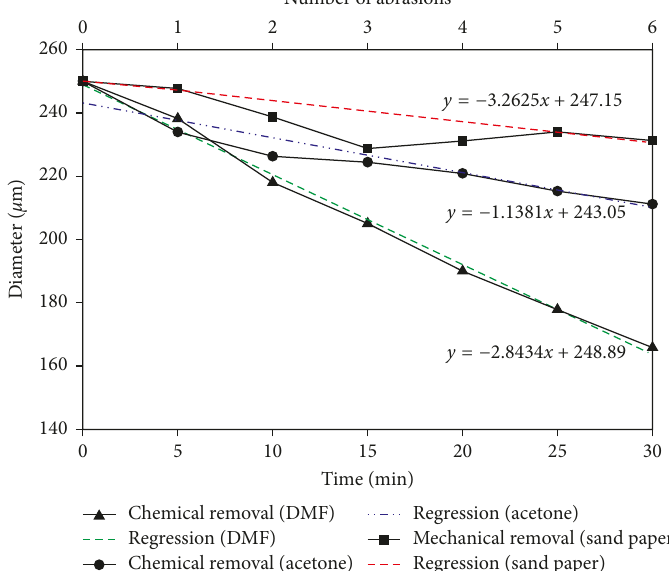
Figure 15: Relationship between acetone immersion time and clad removal effect (for